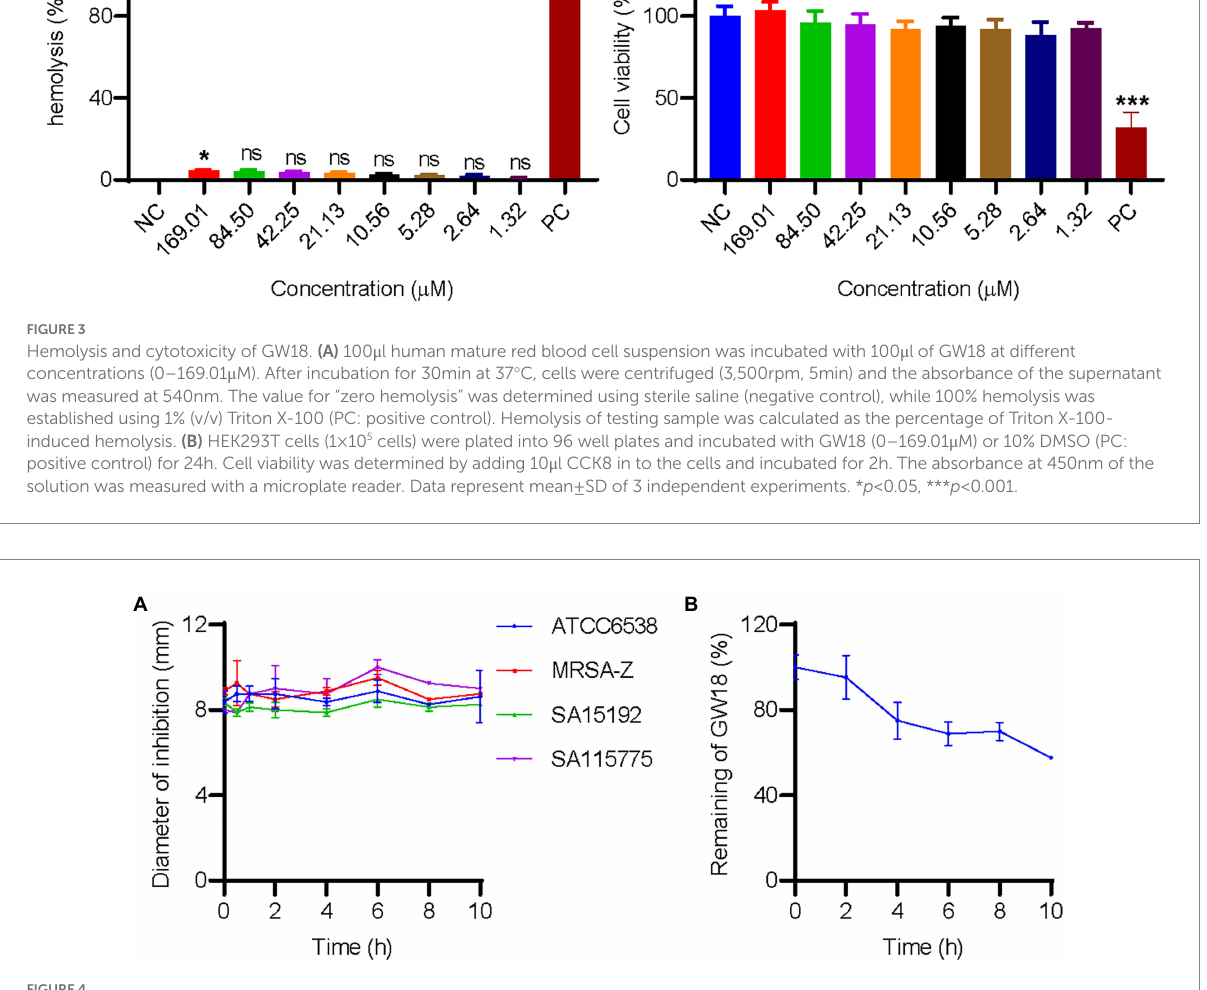
FIGURE 4 GW18 maintains its antibacterial activity against S. aureus in plasma. (A) GW18 was incubated with human plasma (final concentration 4.23 mM) and the stability of GW18 determined by evaluating the antibacterial activity against S. aureus (ATCC6538, MRSA-Z, SA15192, SA115775) using the disk diffusion assay by measuring the diameter of zone of inhibition after incubation for 0–10 h. (B) GW18 was incubated with human plasma (4.23 mM) and the remaining peptide was determined by RP-HPLC. Data represent mean ± SD of two independent